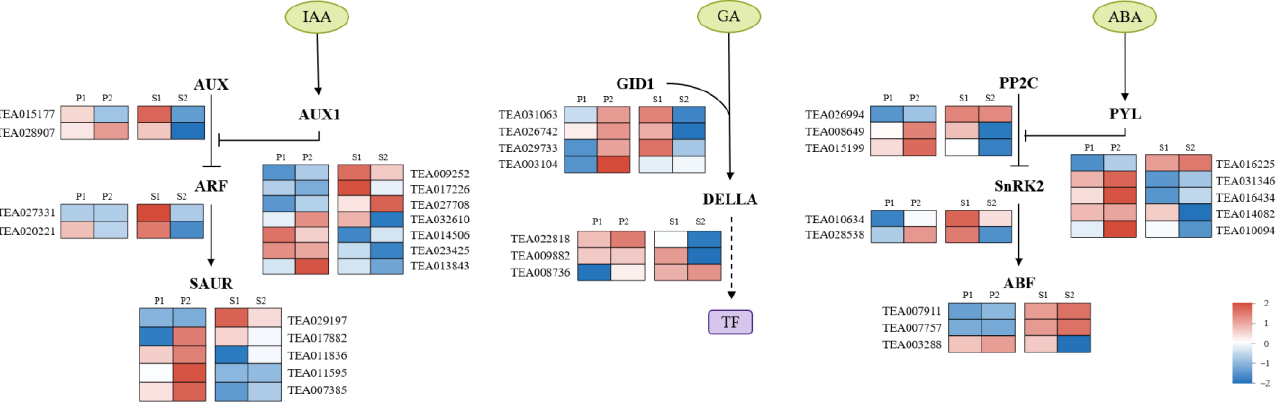
Figure 6. Heatmap of gene expression for DEGs enriched in the ‘plant hormone signal transduction’ pathway. Major enzymes in IAA, GA, and ABA signal transduction pathways are shown. Promotion or inhibition is indicated by arrows and blocks, respectively. Purple box and dotted arrow indicated the transcription factors and ubiquitination process, respectively. P1: pericarp in August; P2: pericarp in September; S1: seeds in August; S2: seeds in September.